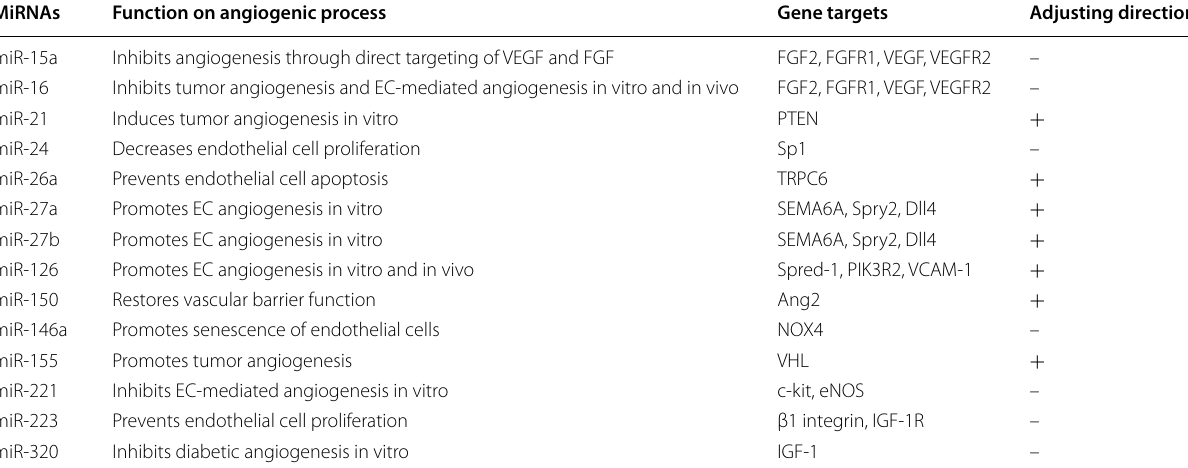
Table 1 Summary of candidate MSC - VEC -miRNAs Regulation in vascular endothelial cells